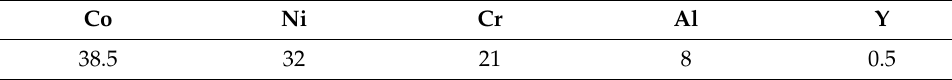
Table 1. Chemical composition of CoNiCrAlY (wt.%) [25].